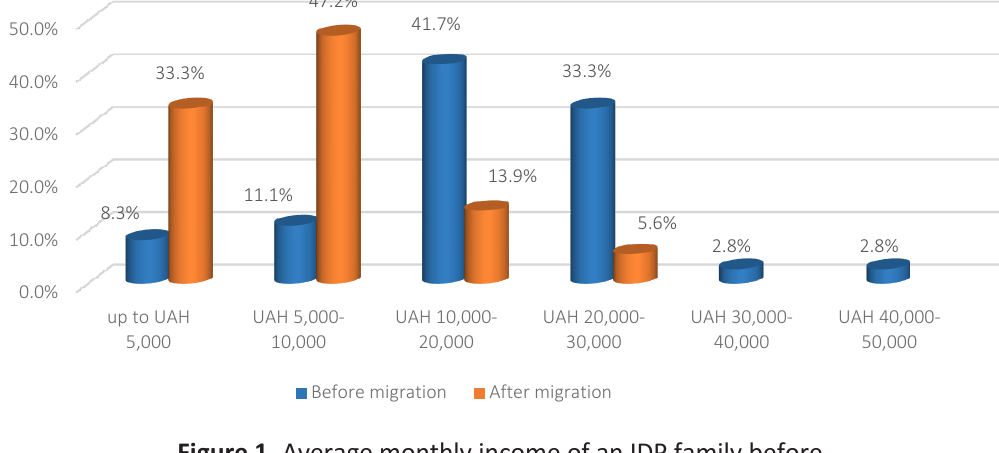
Figure 1. Average monthly income of an IDP family before and after a forced migration, % of respondents